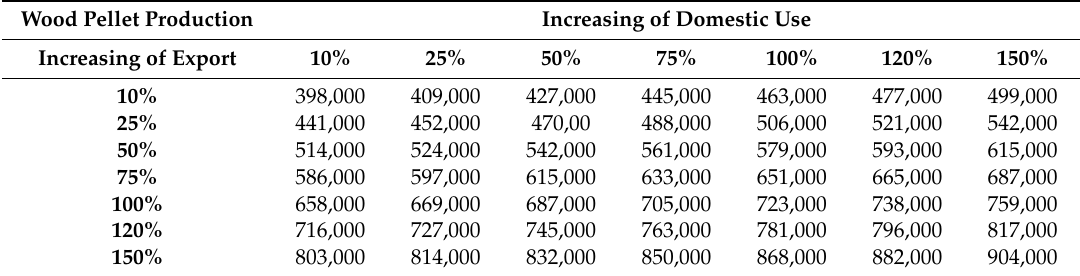
Table 2. Evaluating of wood pellet demand by increasing export and domestic use (tonne).